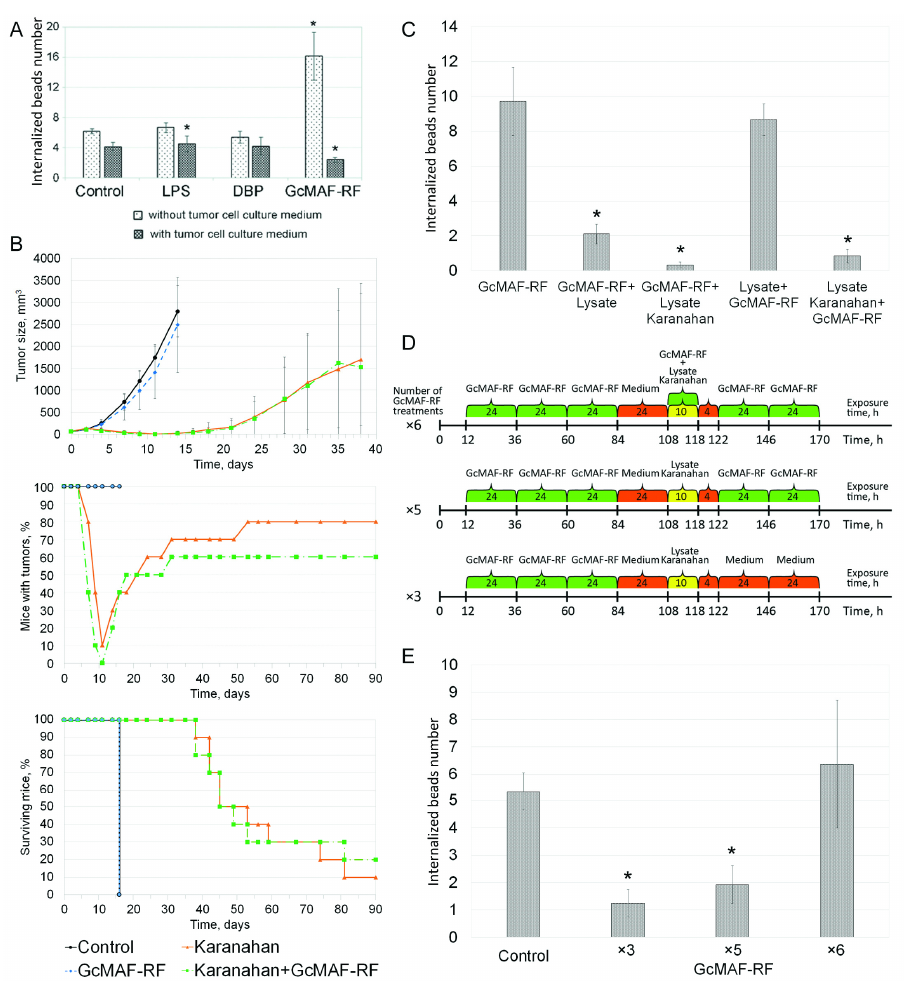
Figure 5. Analysis of antitumor properties of GcMAF-RF. ( A ) Effect of tumor cell culture